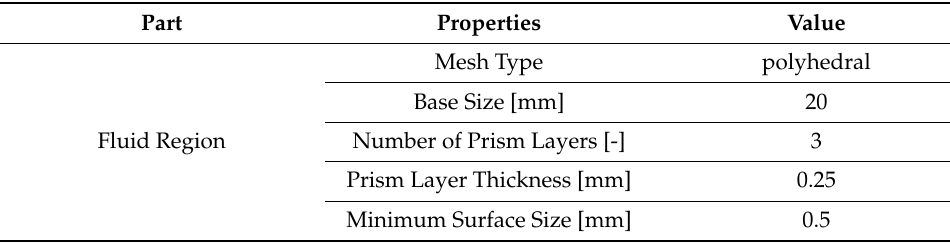
Table 3. Calculation grid settings used for fluid analysis.